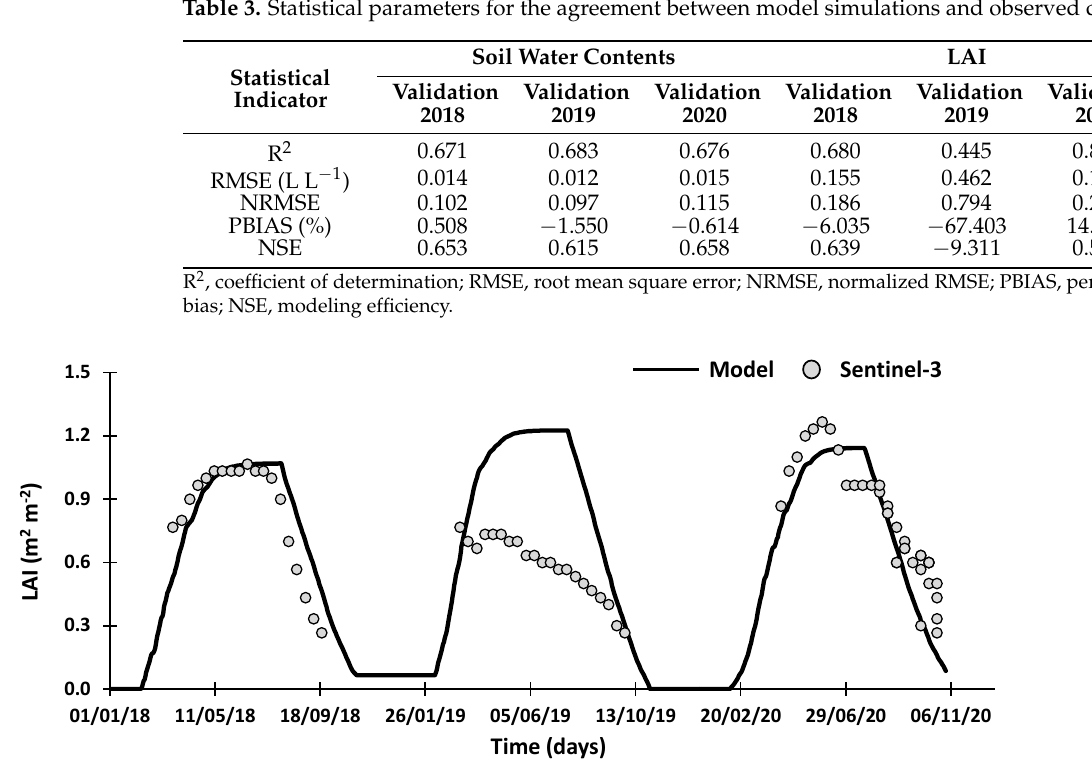
Figure 4. Satellite and simulated leaf area index (LAI) data during the 2018, 2019, and 2020 growing seasons.